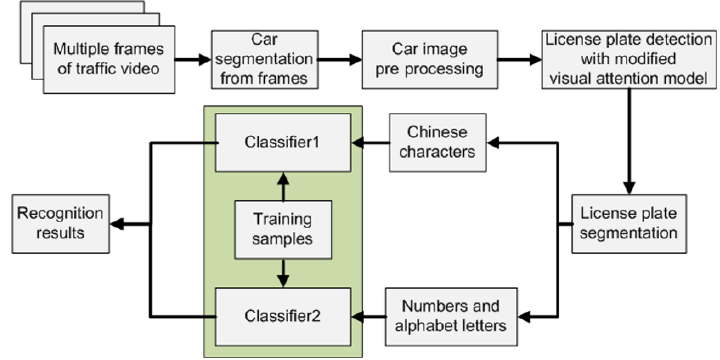
Fig. 1 The overall architecture of the